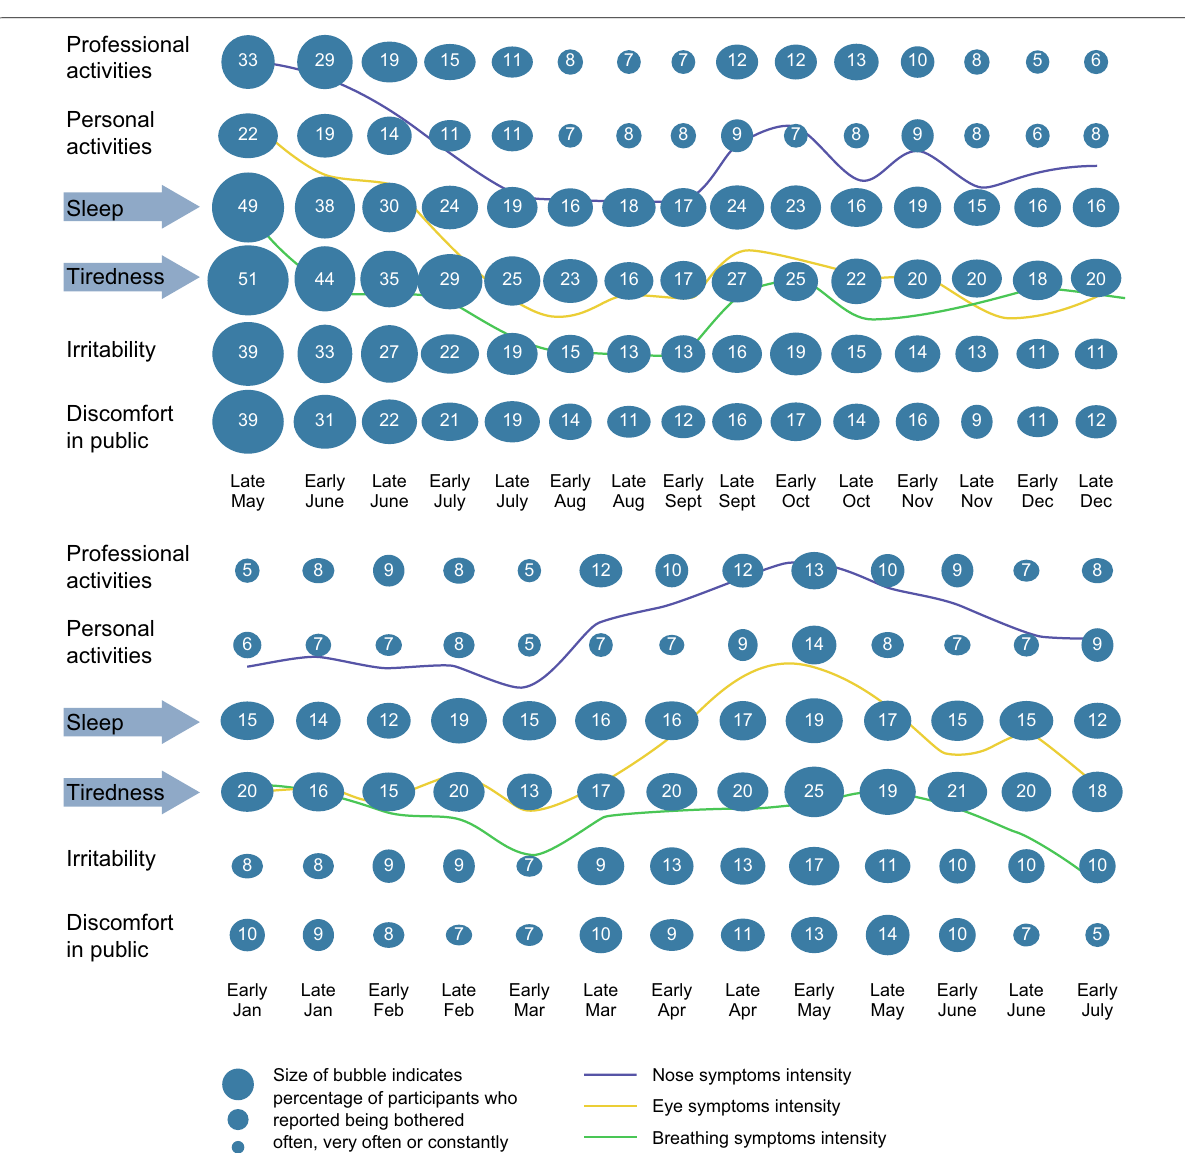
Fig. 3 Fortnightly telephone interviews of study participants: the change over time in the impact of allergy on six types of life activity, from late May to December 2012 (top panel) and from January to July 2013 (bottom